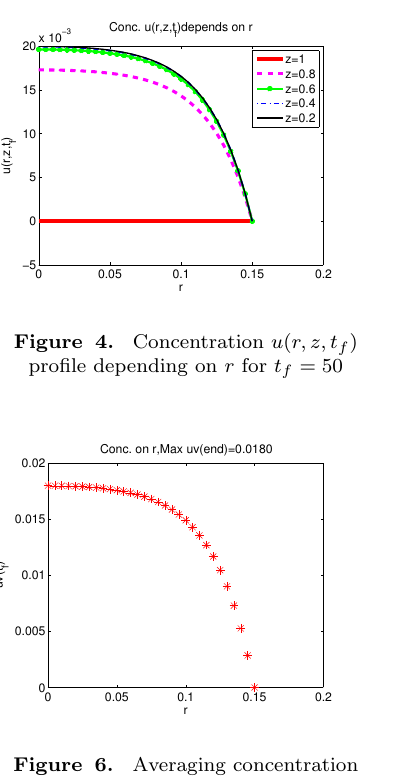
Figure 7. Averaging concentration u vv ( t 1 ) and a vv ( t 1 ) depending on t